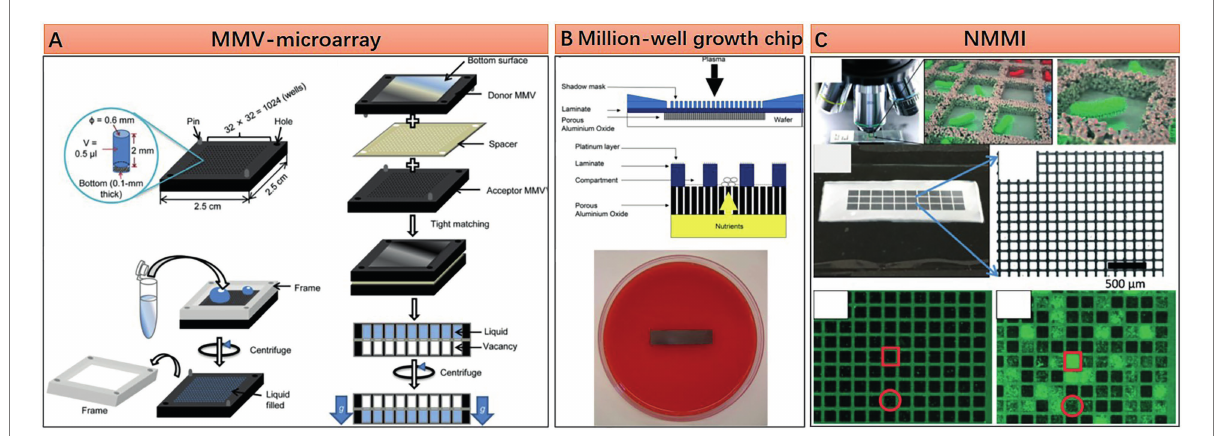
FIGURE 3 Structural features and working principle of diverse microfluidic microwell array approaches. (A) An microarray with manageable volumes (MMV)- microarray with 2.5 by 2.5 cm dimension contains 1,024 wells of 0.5 μ l volume each, manipulation of liquid in each microwell is based on well-to- well transferring with the assistance of silicone or urethane spacer (Reprinted from Sharma et al., 2014 with the permission of Springer Nature and the author); (B) Million-well growth chip, for an 8 × 36 mm chip, there are 180,000 compartments with 20 by 20 μ m dimension each, porous aluminum oxide located under the compartments for nutrition and metabolic waste diffusion (Reprinted from Ingham et al., 2007 with the permission of National Academy of Sciences); and (C) Nanoporous microscale microbial incubators (NMMI), the wall is constructed by HEMA– EDMA hydrogel, the pore size is small enough to allow diffusion of metabolites but not the cells (Reprinted from Ge et al., 2016 with the permission of Royal Society of